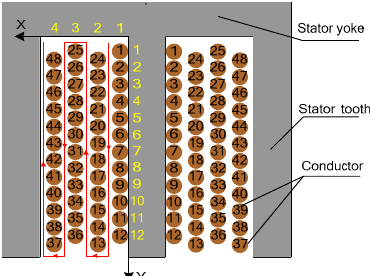
Figure 3. The distribution of the turns in the slot.